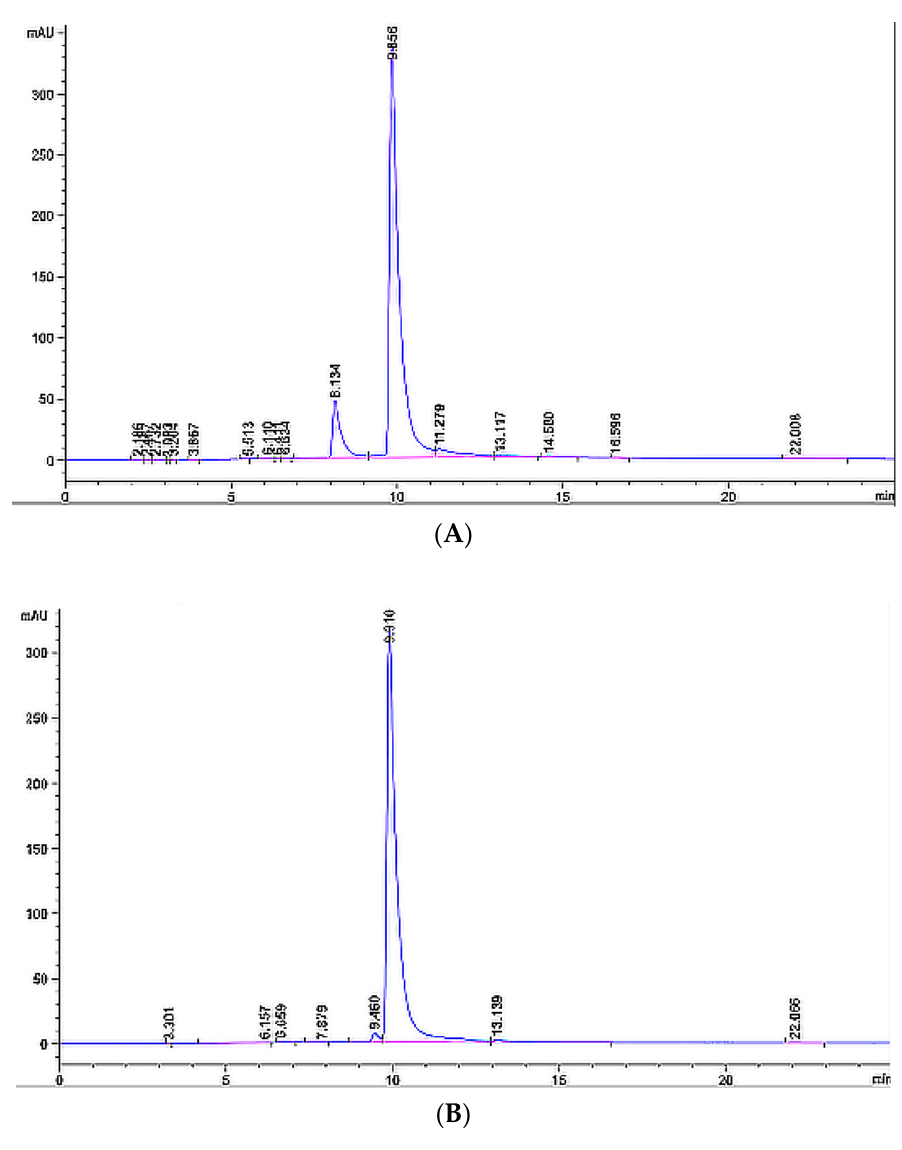
Figure 2. HPLC(High Performance Liquid Chromatography) detection of EGCG. (A) HPLC spectrum of EGCG standard; (B) MOF Zn(BTC) 4 loading of EGCG.